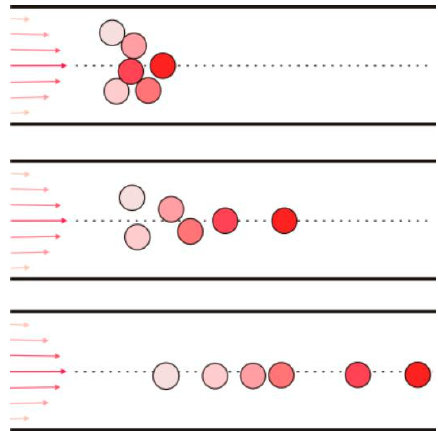
Figure 3. Nanoparticle movement in a long needle. The particle in the center moves fastest, and that far from the center moves slowly and is pushed gradually into the center.